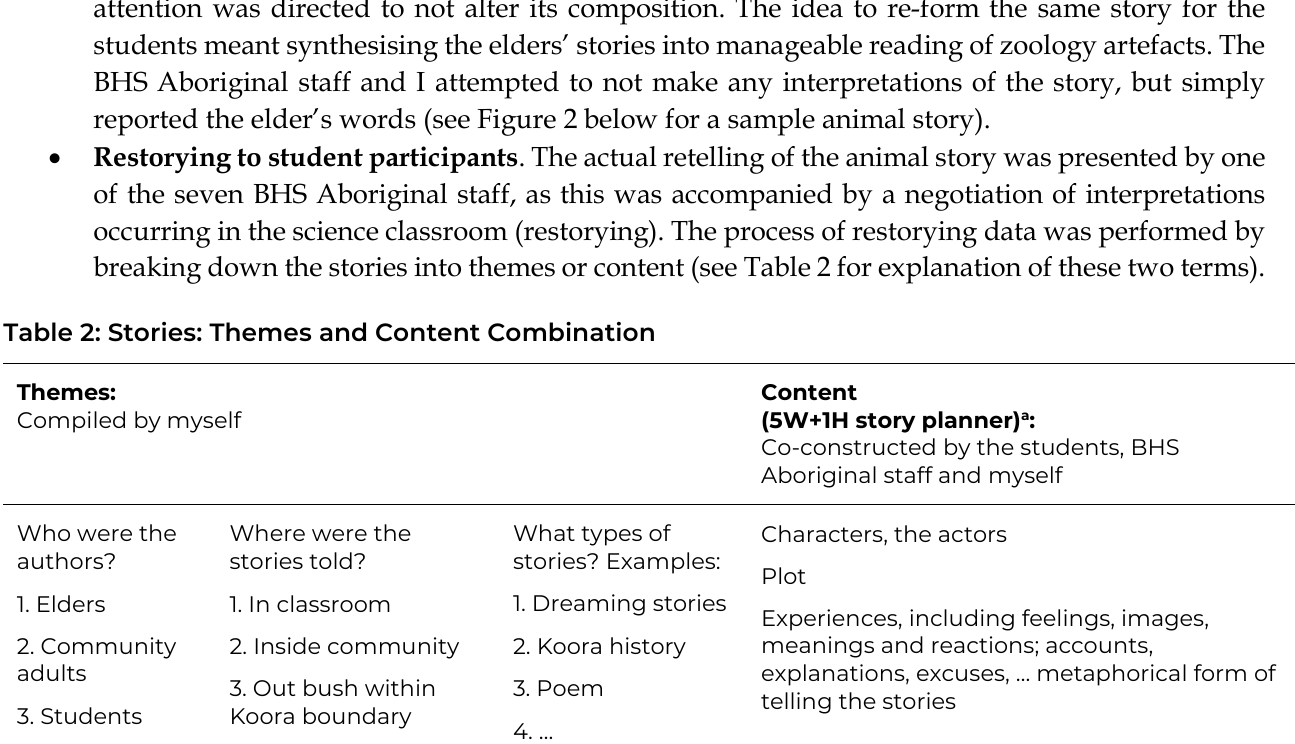
Figure 2: Boongarra, Uncle Wallace’s Dingo or Wuyu: Freedom and Reverence for the Bush Wuyu means “dingo" in language. The name of my pet dingo is Boongarra! Dingoes lived with